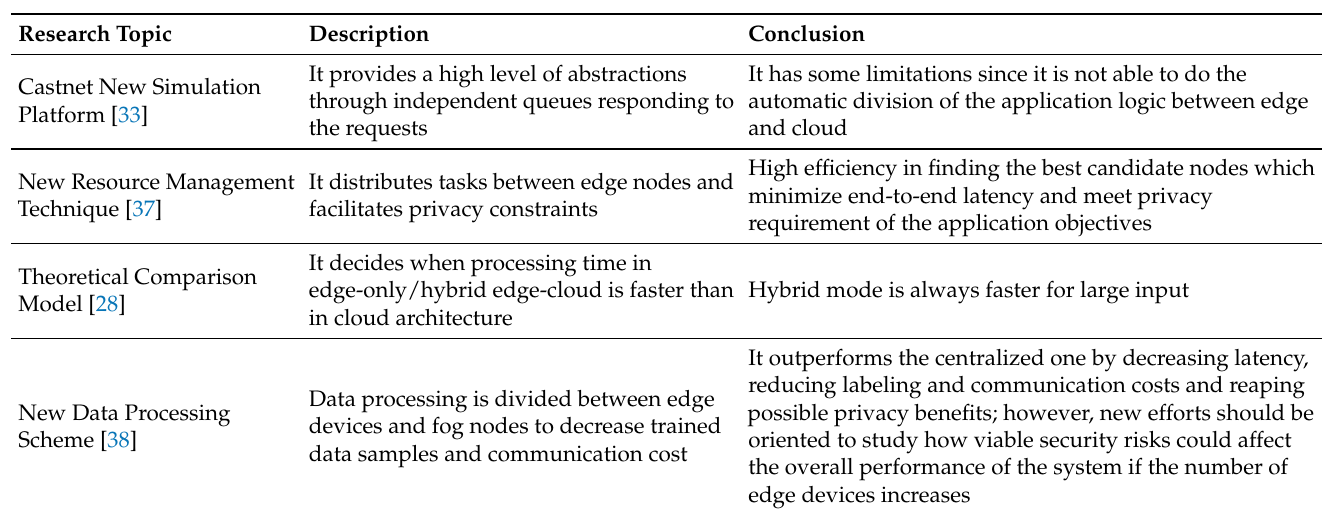
Table 2. Overview of research works cited in Sections